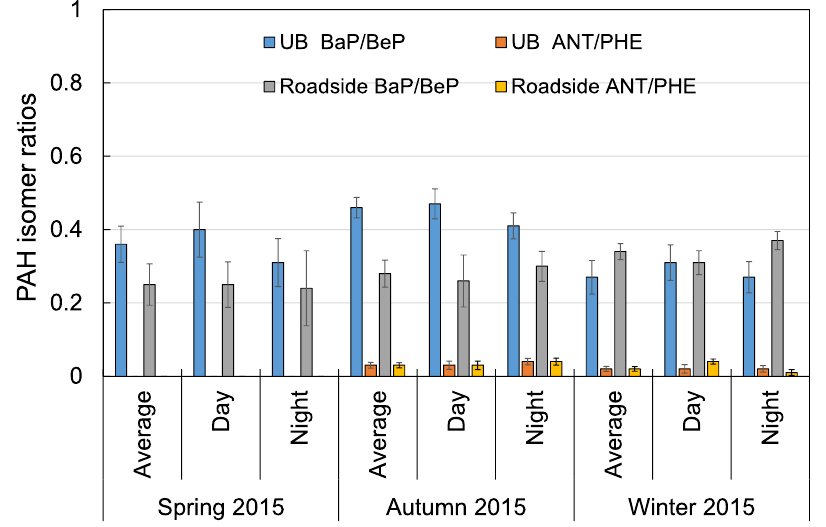
Figure 4. PAH isomer ratios at the urban and roadside sites in